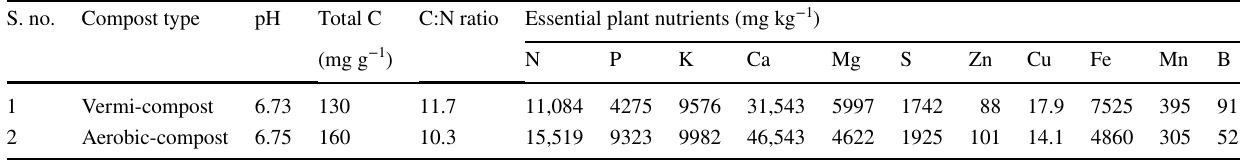
Table 4 Chemical analysis results for mature vermi- and aerobic-compost at 60-day stage of decomposition S. no. Compost type